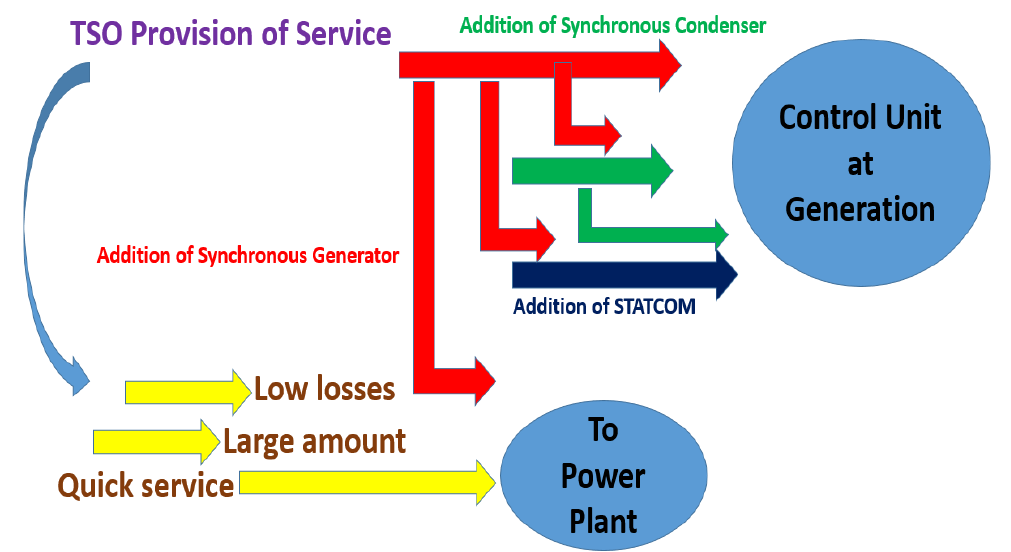
Figure 1. Transmission System Operator (TSO) needs vs. Approach of controller.